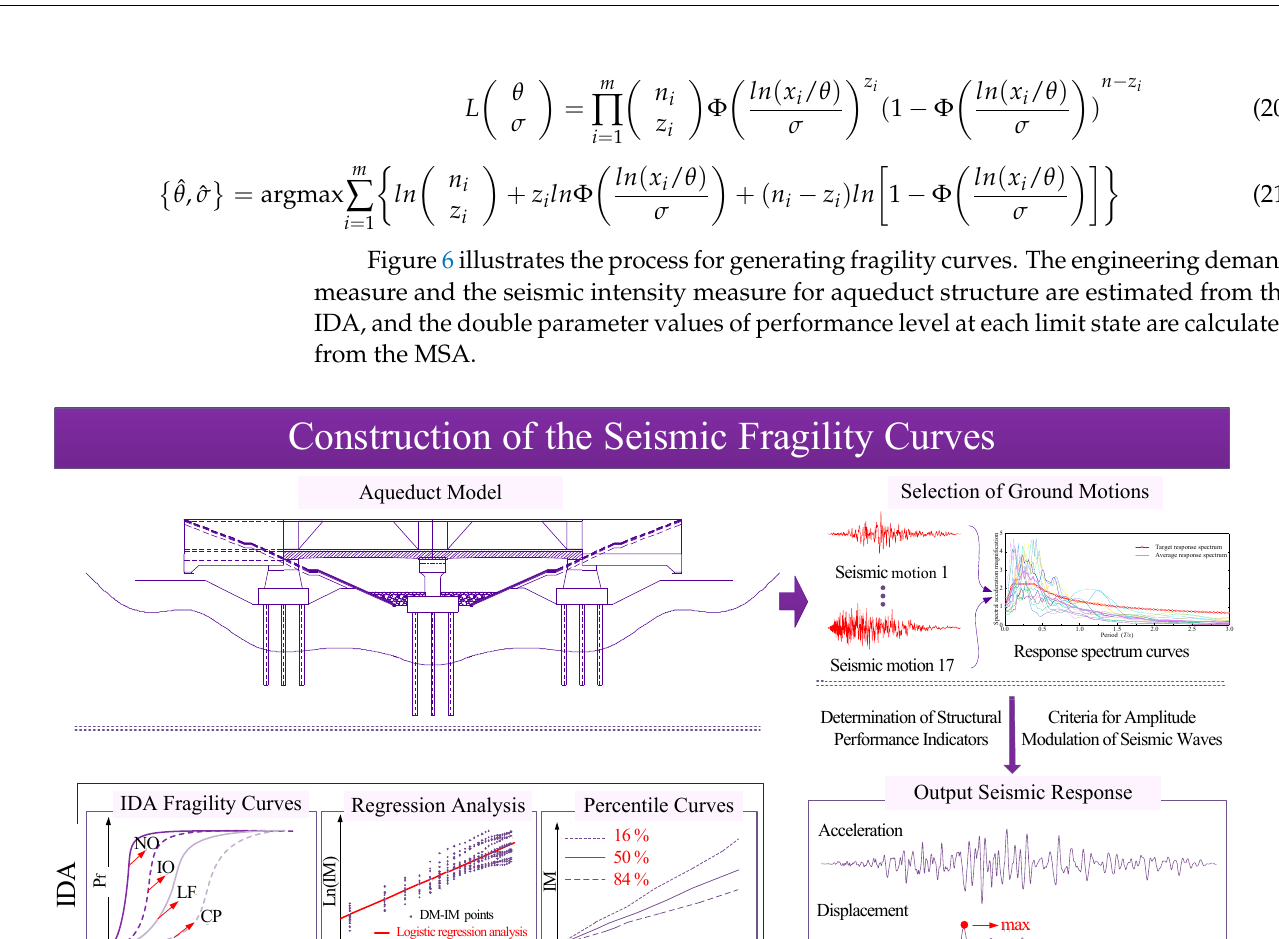
Figure 7. Response spectrum curves.